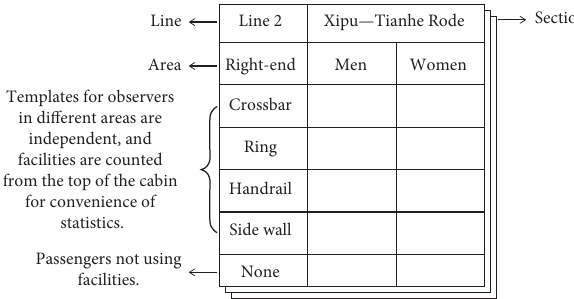
Figure 2: Sample of the record template used by the